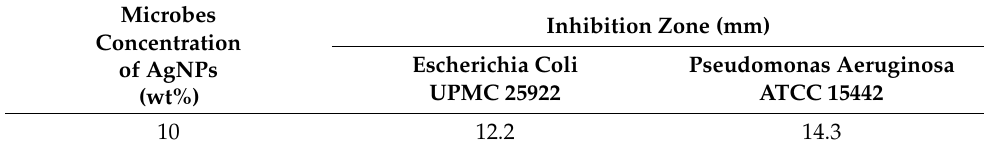
Table 4. Antibacterial study of kenaf/HDPE composites.